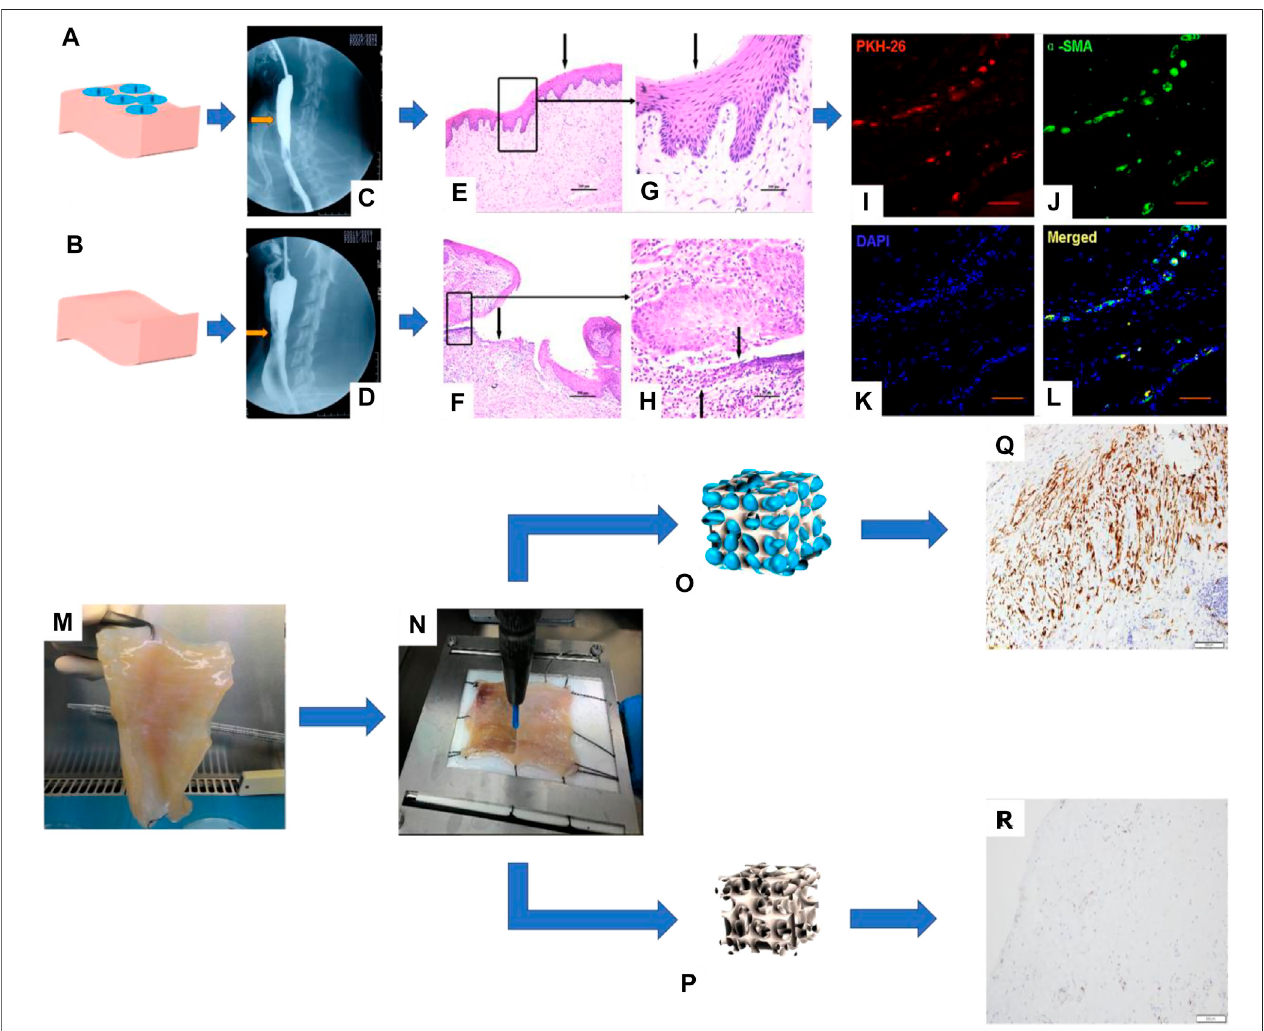
FIGURE 2 | I. Repair of a canine esophageal defect with SIS combined with MSCs. (A) SIS + MSCs. (B) Simple SIS. (C, D) Barium esophagus examination. (E, F) H&E staining of canine esophagus tissue and (G, H) its partial magni fi cation. (I – L) Immuno fl uorescence staining to detect the expression of living cell marker proteins PKH-26 and α -SMA in canine esophagus tissue (Tan et al., 2013). II. Esophageal muscular acellular matrix repairs porcine esophageal defects: (K) Porcine esophageal muscular acellular matrix. (L) Microscopic perforation treatment. (M, N) Schematic diagram of MSC growth in the acellular matrix scaffold. (O, P) Immunohistochemical staining to detect the expression of actin and desmin in porcine esophagus tissue (Marzaro et al., 2020).